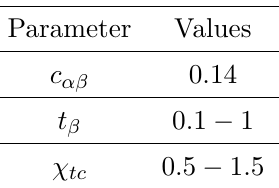
Figure 2. Allowed region by the reported upper limit by ATLAS (orange area) and by extrapolation (green area).